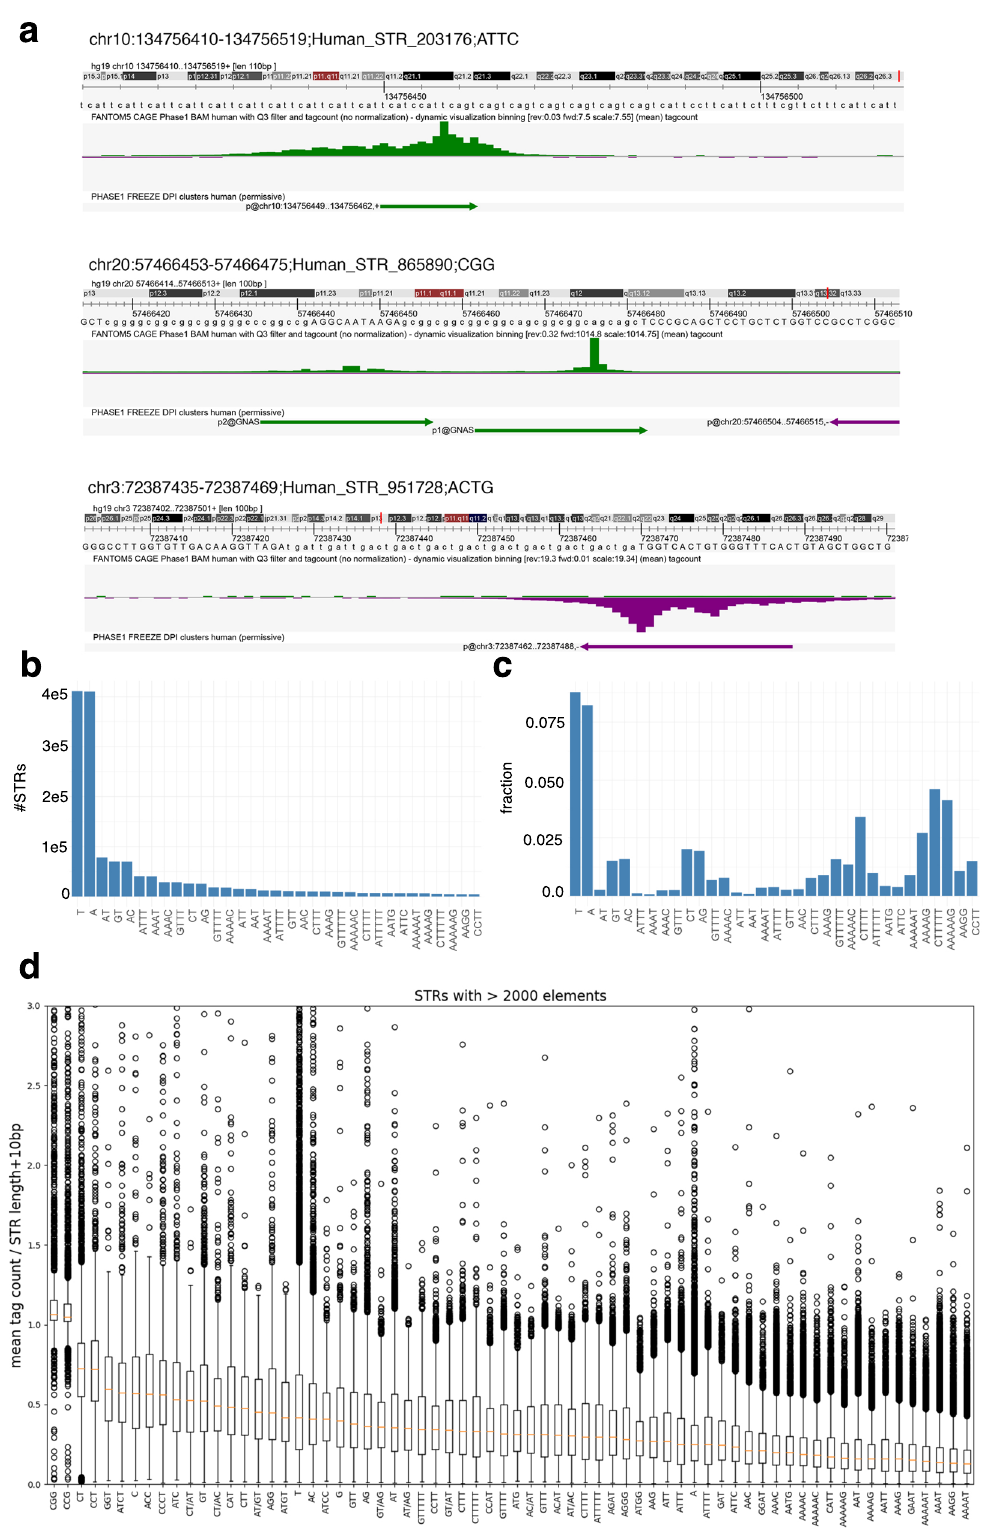
then evaluated the existence of this G bias in CAGE tags corre- sponding to peaks detected at STRs, peaks assigned to genes (for positive control), and peaks intersecting the 3 ’ end of precursor microRNAs (pre-miRNAs for a negative control) (Fig. 2). While most CAGE tag 5 ’ ends perfectly match the sequences of pre- miRNA 3 ’ end in all cell types tested, as previously reported 38 , a G